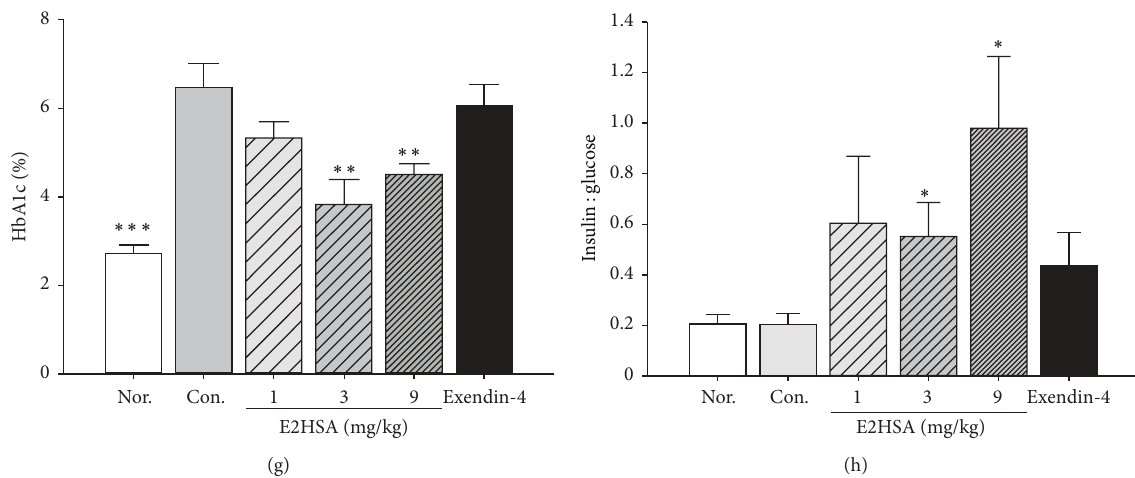
Figure 4: Chronic treatment with E2HSA improved glycemic control in spontaneous type 2 diabetes db/db mice. (a) Nonfasting blood glucose levels normalized by setting blood glucose levels in the control group to 100%. The mini figure shows the nonfasting blood glucose levels at 1 hour and 5 hours after E2HSA and exendin-4 administration on the first day. (b) Changes in fasting blood glucose levels relative to levels before E2HSA treatment. ((c) and (d)) Blood glucose curves and AUC of OGTT on the 2nd week. ((e) and (f)) Blood glucose curves and AUC of OGTT on the 5th week. (g) HbA1c levels on the 37th day. (h) Insulin/glucose ratios at 10 minutes following glucose challenge on the 5th week. Nor., db/m mice administered normal saline. Con., db/db mice administered normal saline. Data are expressed as mean ± S.E.M ( 𝑛 = 10 - 11 ). ∗ 𝑃 < 0.05 , ∗∗ 𝑃 < 0.01 , and ∗∗∗ 𝑃 < 0.001 versus